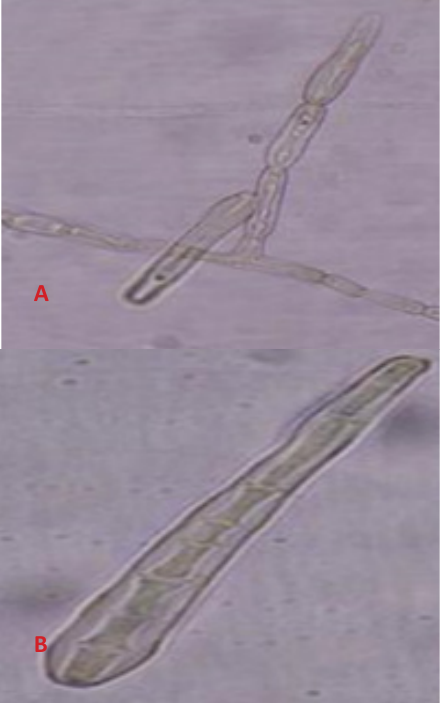
Figure 3. Fruiting structures of C. cassiicola observed under a microscope: A) Conidiophore and conidia in formation. B) Conidia with transverse